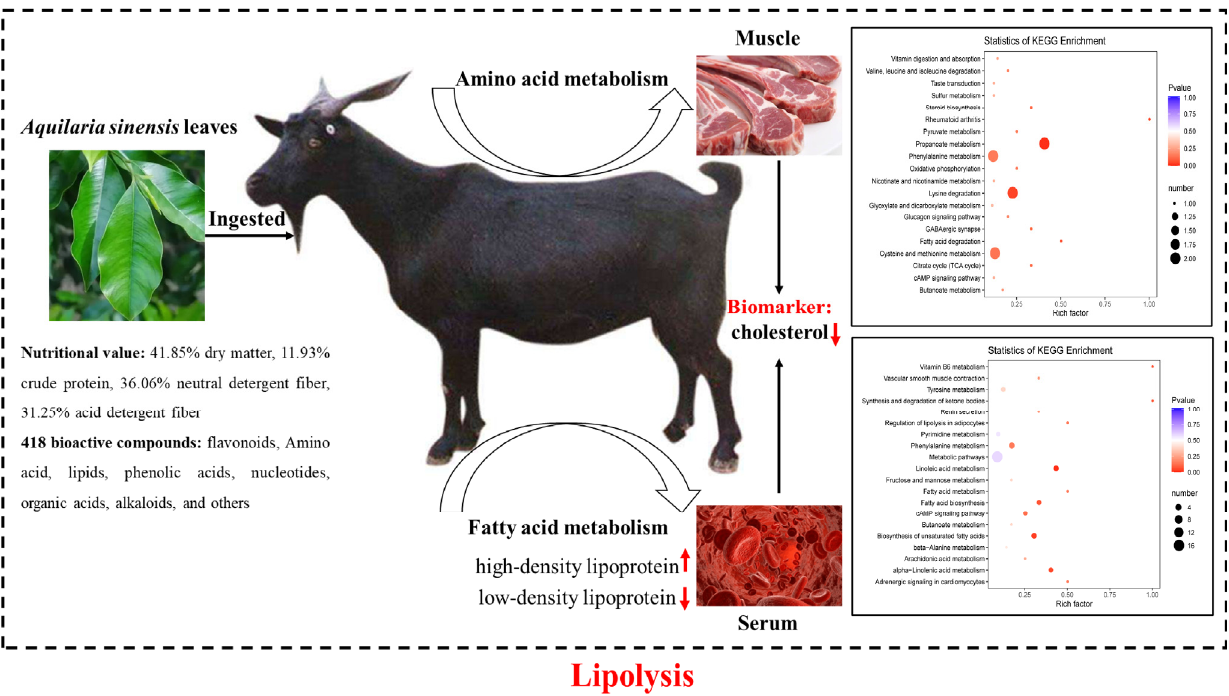
Figure 5. A schematic diagram of responses to feeding A. sinensis leaves to goats. A. sinensis leaves are rich in linolenic acids, flavonoids, and phenolic acids that play the role of hypolipidemic in goats via the modulation of the lipid metabolism signaling pathway. The reduction in blood cholesterol and low-density lipoprotein levels and the increase in high-density lipoprotein levels in goats in response to the diet strongly implied the activation of lipolysis metabolism during feeding A. sinensis leaves.